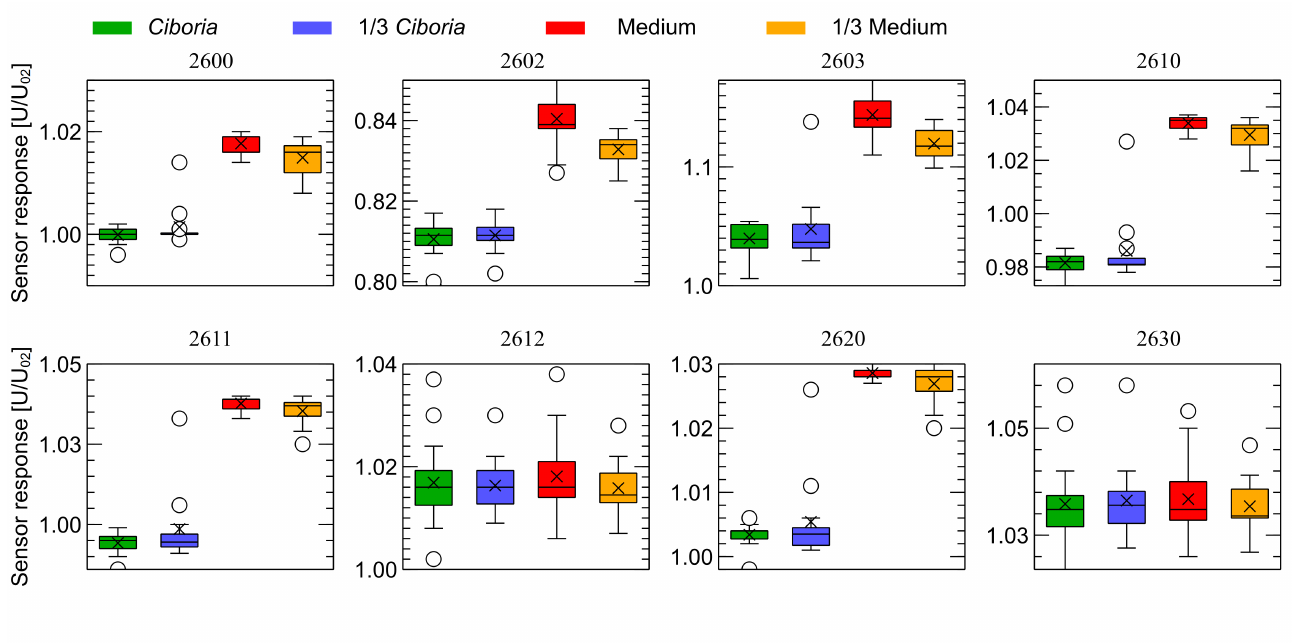
Figure 8. Distribution of the sensor response magnitude collected at the moment of 150 sensor reads from the beginning of the first observation stage (Figure 6). Comparison of four categories of samples used in the experiments.